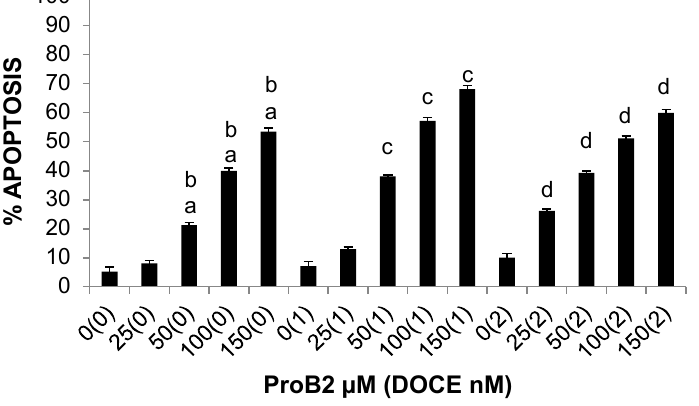
Figure 7. DAPI assay results showing apoptosis of DU145 cells under different concentrations of the test compound (ProB2, DOCE, ProB2 + DOCE) at 72 h. Columns, mean; bars, SE ( n = 3). a represents the significant difference between ProB2 treatment alone and control treatment; b represents the sig- nificant difference between ProB2 treatment alone and 2 nM DOCE alone; c represents the significant difference between combination treatment (ProB2 + DOCE 1 nM) and DOCE 1 nM alone; d represents the significant difference between combination treatment (ProB2 + DOCE 2 nM) and DOCE 2 nM alone ( p < 0.05; one-way ANOVA). Abbreviations: DOCE, docetaxel; ProB2, procya- nidin B2.